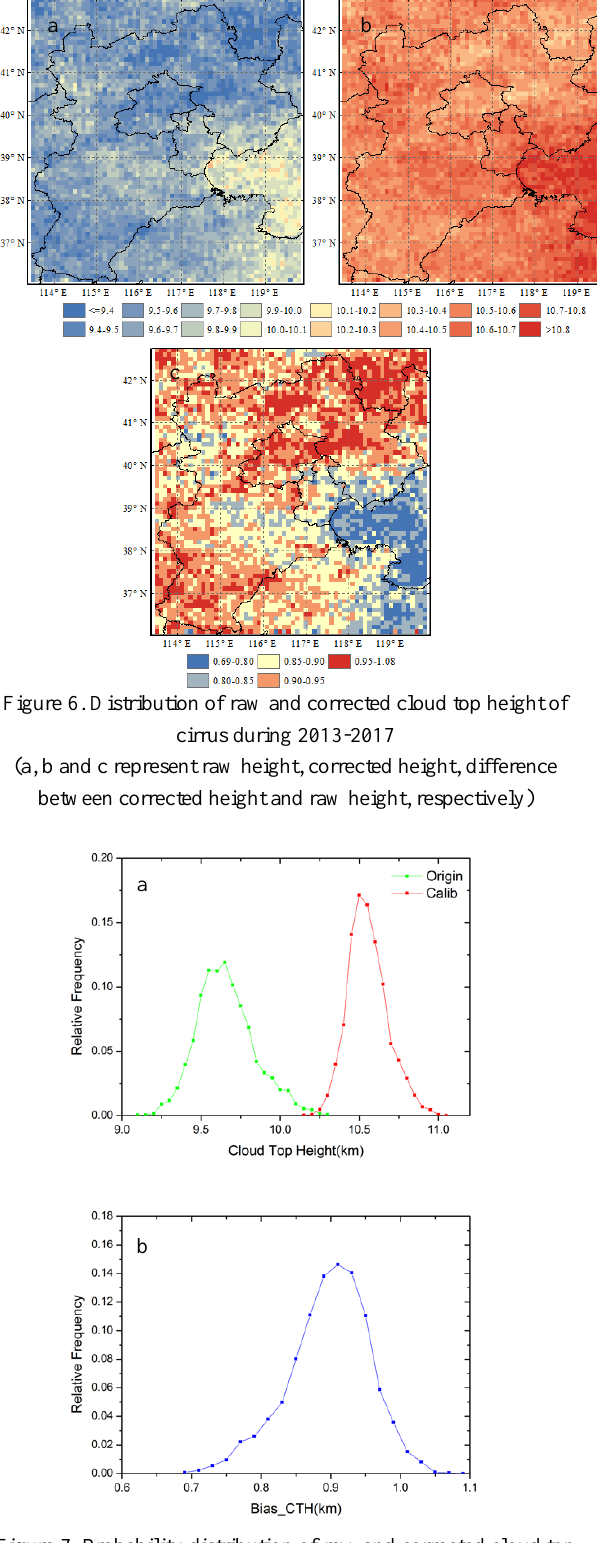
Figure 7. Probability distribution of raw and corrected cloud top height of cirrus during 2013-2017 (a represents raw height and corrected height, green and red line represent raw height and corrected height, respectively, b represents the difference between corrected height and raw